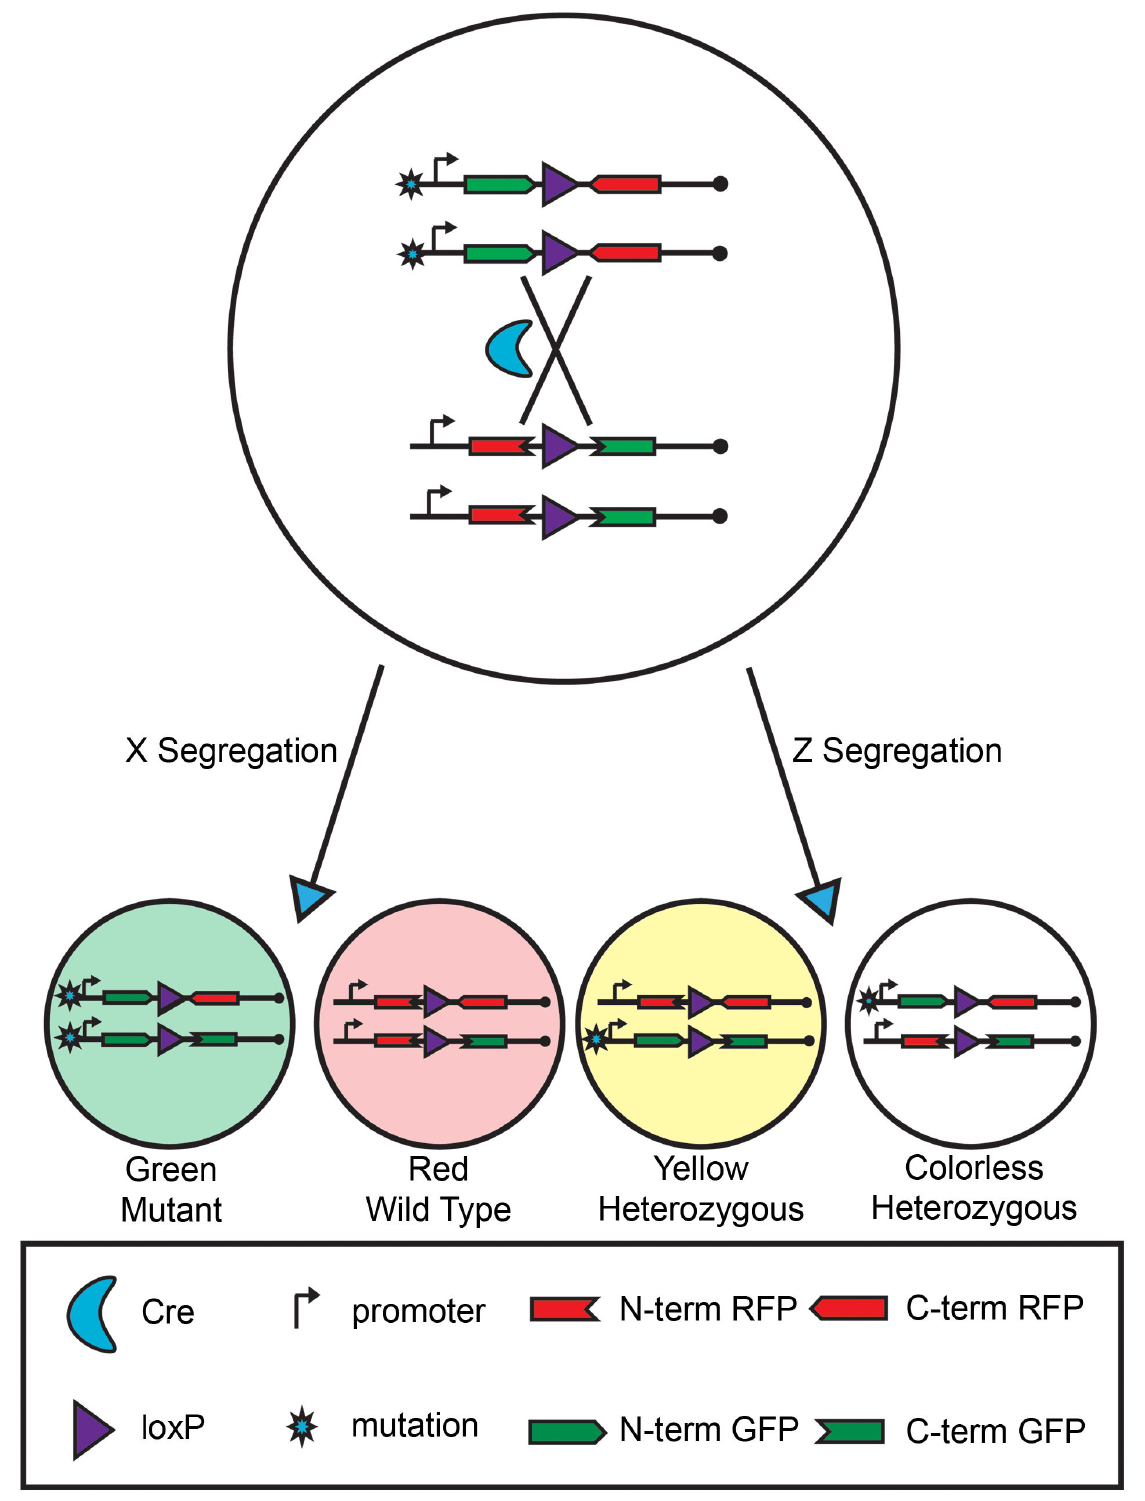
Figure 1. The MADM system. MADM generates sibling green mutant and red wildtype daughter cells from a colorless heterozygous progenitor via Cre-loxP mediated mitotic recombination followed by X segregation. MADM can also generate yellow and colorless heterozygous cells when mitotic recombination is followed by Z segregation. doi: 10.1371/journal.pone.0077672.g001 PLOS ONE |